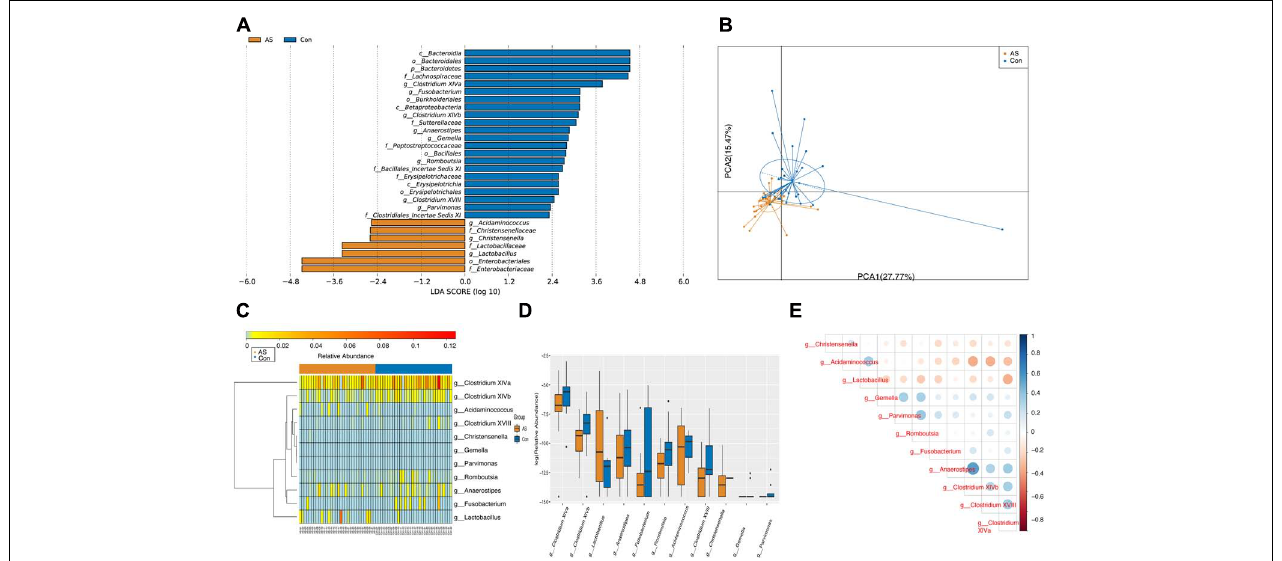
FIGURE 3 | Differentially enriched gut microbiota for CAS patients and healthy controls. (A) A total of 29 different features screened by LEfSe at phylum ( n = 1), class ( n = 3), order ( n = 5), family ( n = 9), and genus ( n = 11) level with a threshold of LDA > 2. (B) PCA plot demonstrated that CAS group is significantly different from control group based on differential genera. (C,D) Differentially enriched gut microbiotas were visualized in heatmap and box plot. (E) Associations between differential microbiotas were by correlation heatmap. Bluer color indicates a more positive correlation, whereas redder color indicates a more negative